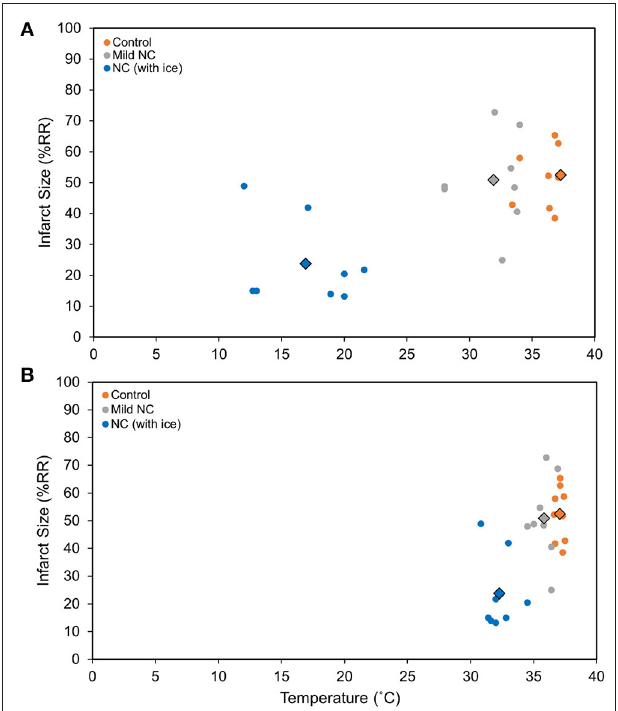
FIGURE 4 | NC attenuates myocardial infarct size in a vagus nerve- and temperature-dependent manner. (A) Neck temperature during implemented therapy compared to infarct size. (B) . Chest temperature during implemented therapy compared to infarct size. Myocardial infarct size was calculated as a percentage of left ventricle area at risk after 40min of left coronary artery occlusion followed by 60min of reperfusion. The average temperature vs. average infarct size for each group is demonstrated with the outlined diamond. Mild NC topical neck cooling with tubing containing room-temperature water; NC (with ice) topical neck cooling with ice-filled tubing initiated 5min after LCA occlusion. RR, risk region.